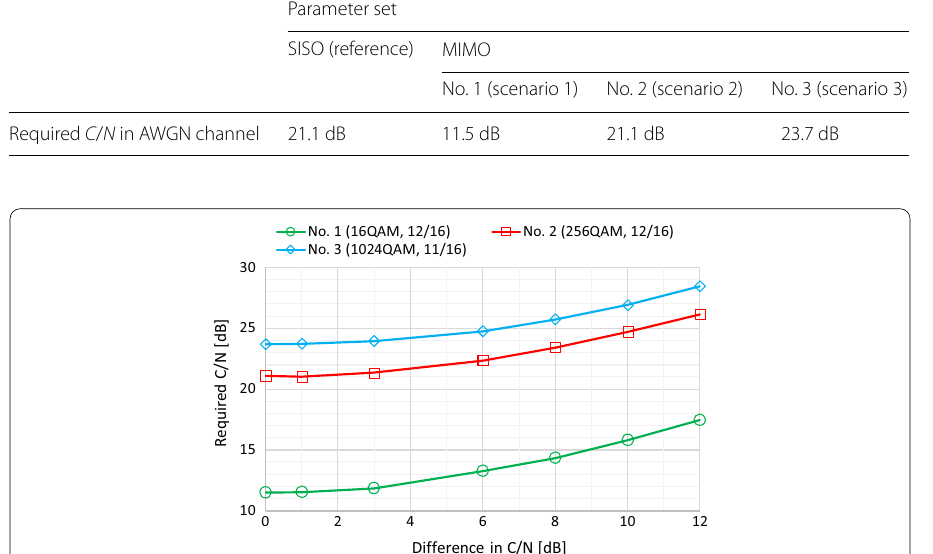
Fig. 11 Required C / N with difference between C / N values for signals #1 and #2 in laboratory